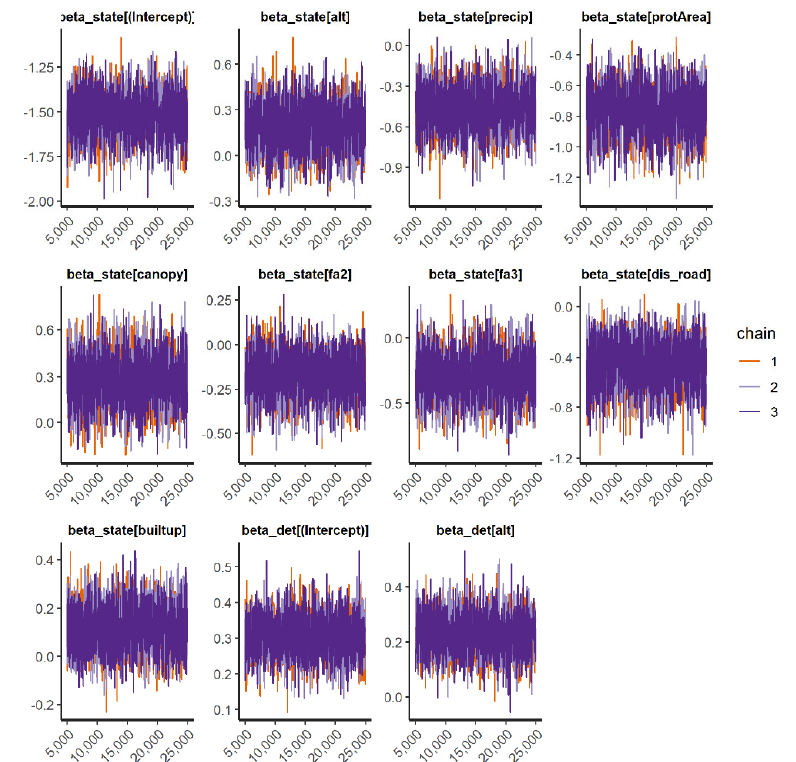
Figure A9. Traceplots from the best occupancy model of chicken ( Gallus gallus domesticus ) in Puerto Rico: ( ψ (intercept + elevation + precipitation + protected area + canopy cover + fa2 + fa3 + distance of road + built-up + RSR-1000); ρ (intercept + elevation)). Note: alt = elevation; precip = mean annual precipitation; protArea = proportion of protected area; canopy = proportion of canopy cover; fa2 = proportion of forest cover aged between 32 and 54 years; fa3 = proportion of forest cover aged 55 years and older; dis_road = minimum distance from road; builtup = built-up proportion; RSR = restricted spatial regression (threshold = 1000 m).